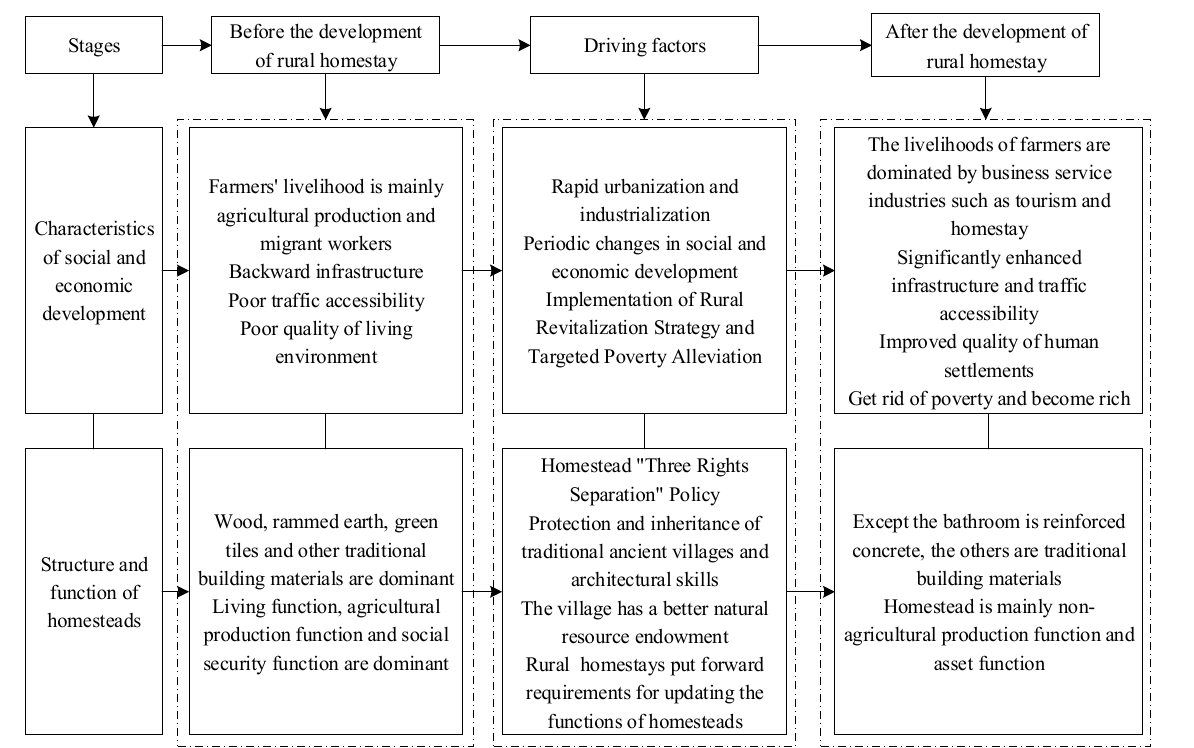
Figure 8. Dynamic mechanism of rural homesteads function evolution in Xiniu Village.